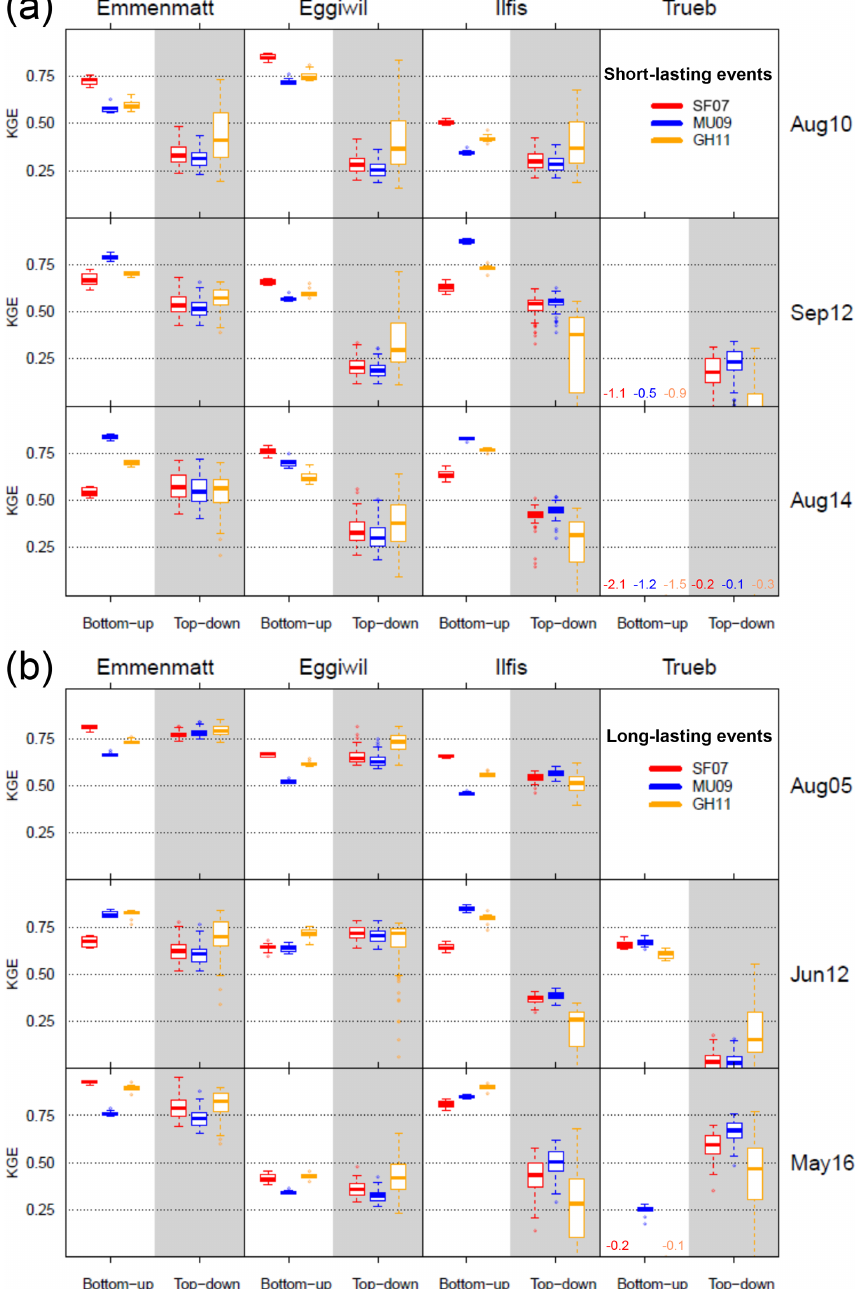
Figure 8. Results from the short-duration (a) and from the long-duration events simulated on the catchments investigated using the benchmark modelling chain. The box plots represent the simulation results of the bottom-up (white background) and of the top-down (grey background) parameterisations, whereas the coloured borders represent the different mapping approaches. In the case of negative performances, the median values are shown. Overall, the bottom-up performed better than the top-down set-up during short-duration events, whereas no preference was found for long-duration